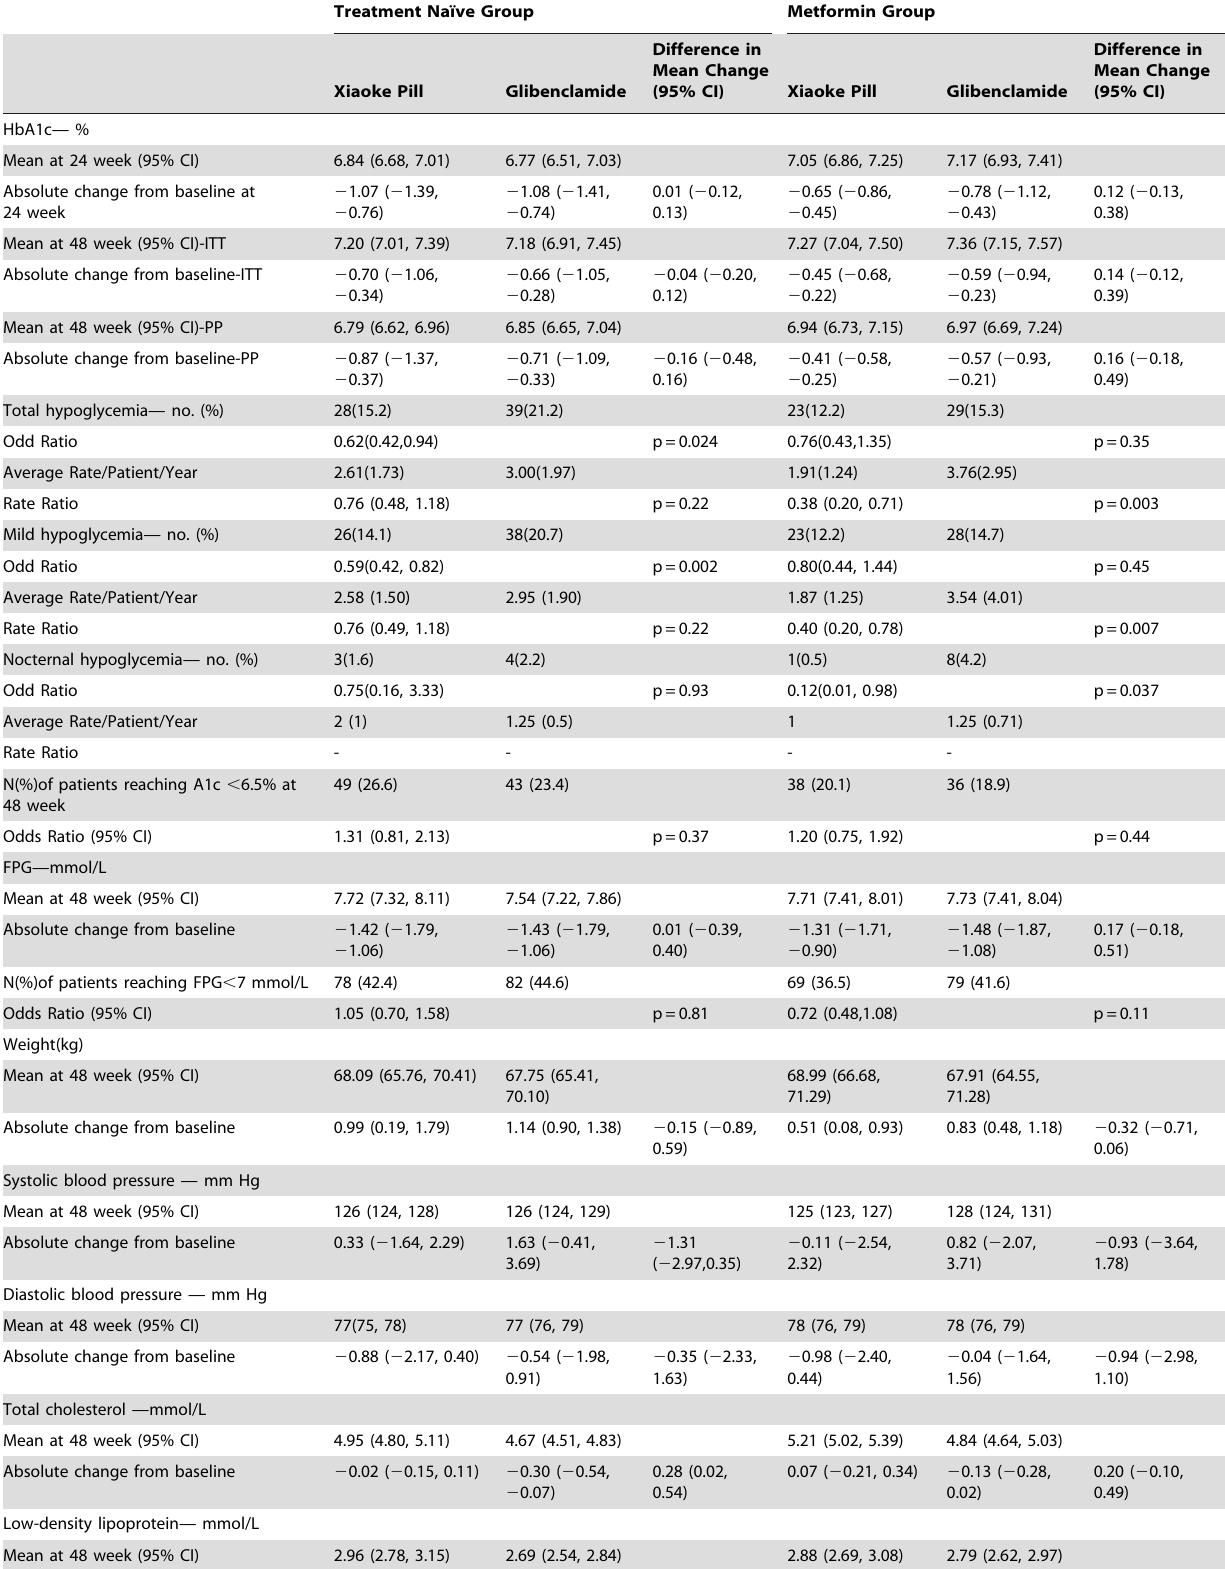
Table 2. Outcomes and changes from